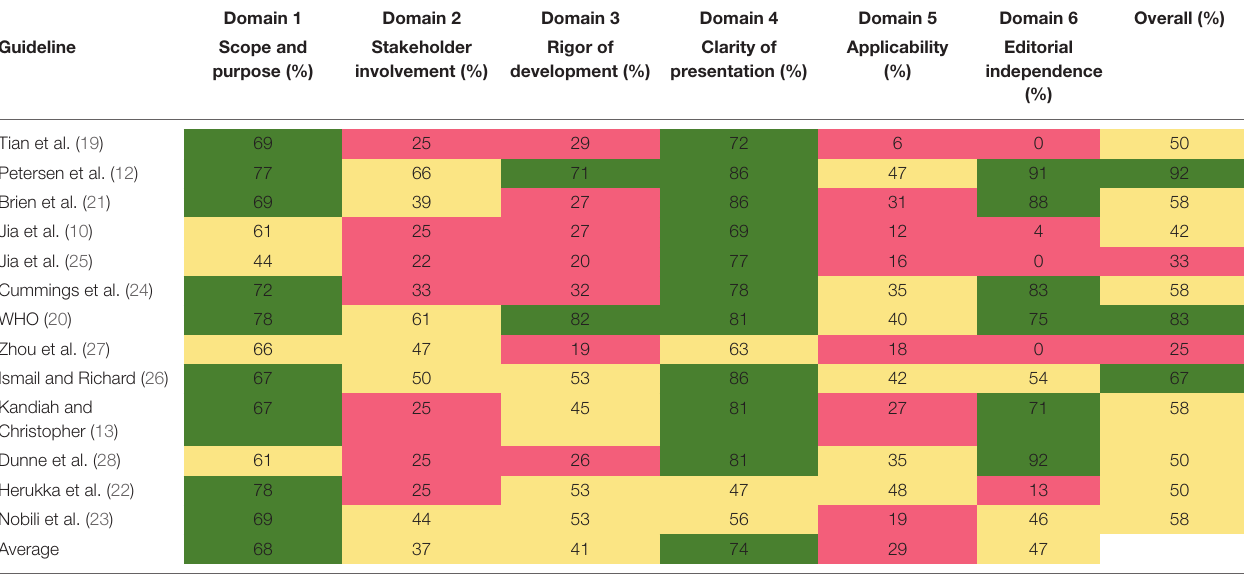
TABLE 2 | Assessment of guidelines and consensus statements by AGREE